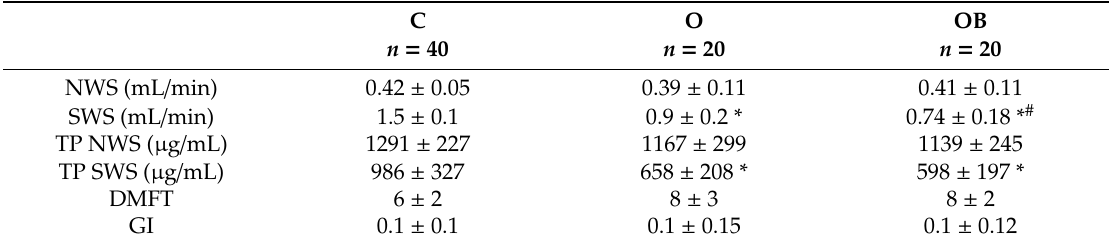
Table 2. Salivary flow rate, total protein and stomatological